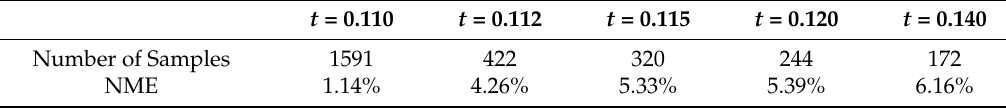
Table 2. Turbidity data sampling results for different threshold values.